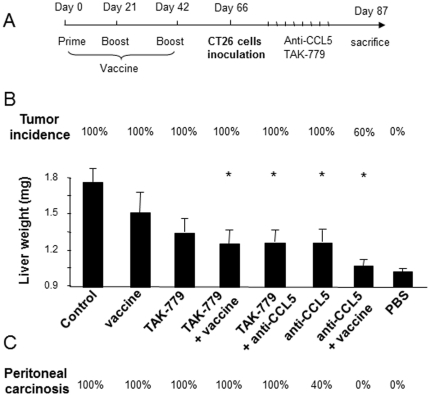
Combining CCL5- and PDGFRβ-directed strategies offers the greatest protection against liver tumors and peritoneal carcinosis.(A) Mice were challenged on day 0, and restimulated on day +21, and day +42 with the DNA vaccine (50 µg) or the control vector formulated with 0.3% poloxamine 704 before receiving three weeks later an injection of CT26 cells under the liver capsule. Seventy two hours later, mice were treated with CCL5-directed antibodies or with TAK-779 or both, as described in the Materials and Methods section. (B) Incidence and extent of tumor development within livers of CT26-challenged mice, immunized or not against PDGFRβ and treated either with anti-CCL5 antibodies, with TAK-779, or with both blockers. (C) Incidence of peritoneal carcinosis expressed as percent of mice bearing carcinosis. (n = 5/group). * p<0.05, ** p<0.01.